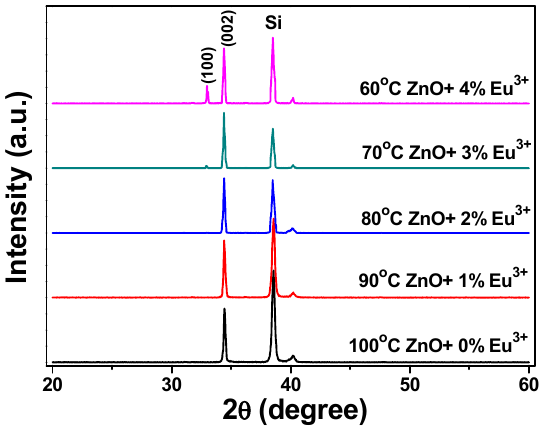
Figure 5. XRD patterns of the synthesized Eu 3+ -doped ZnO nanowires as a function of the concentration of Eu 3+ ions (or synthesis temperature).